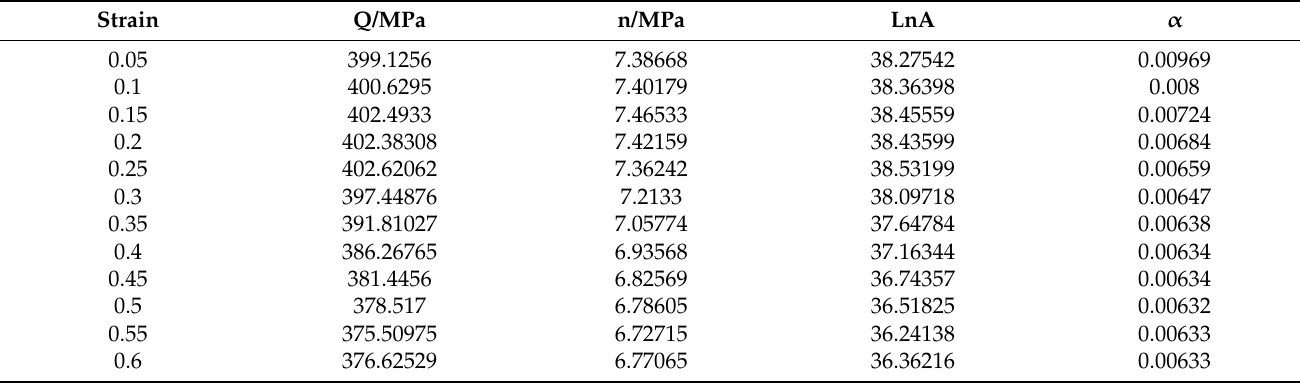
Table 4. The model parameter values under different strain